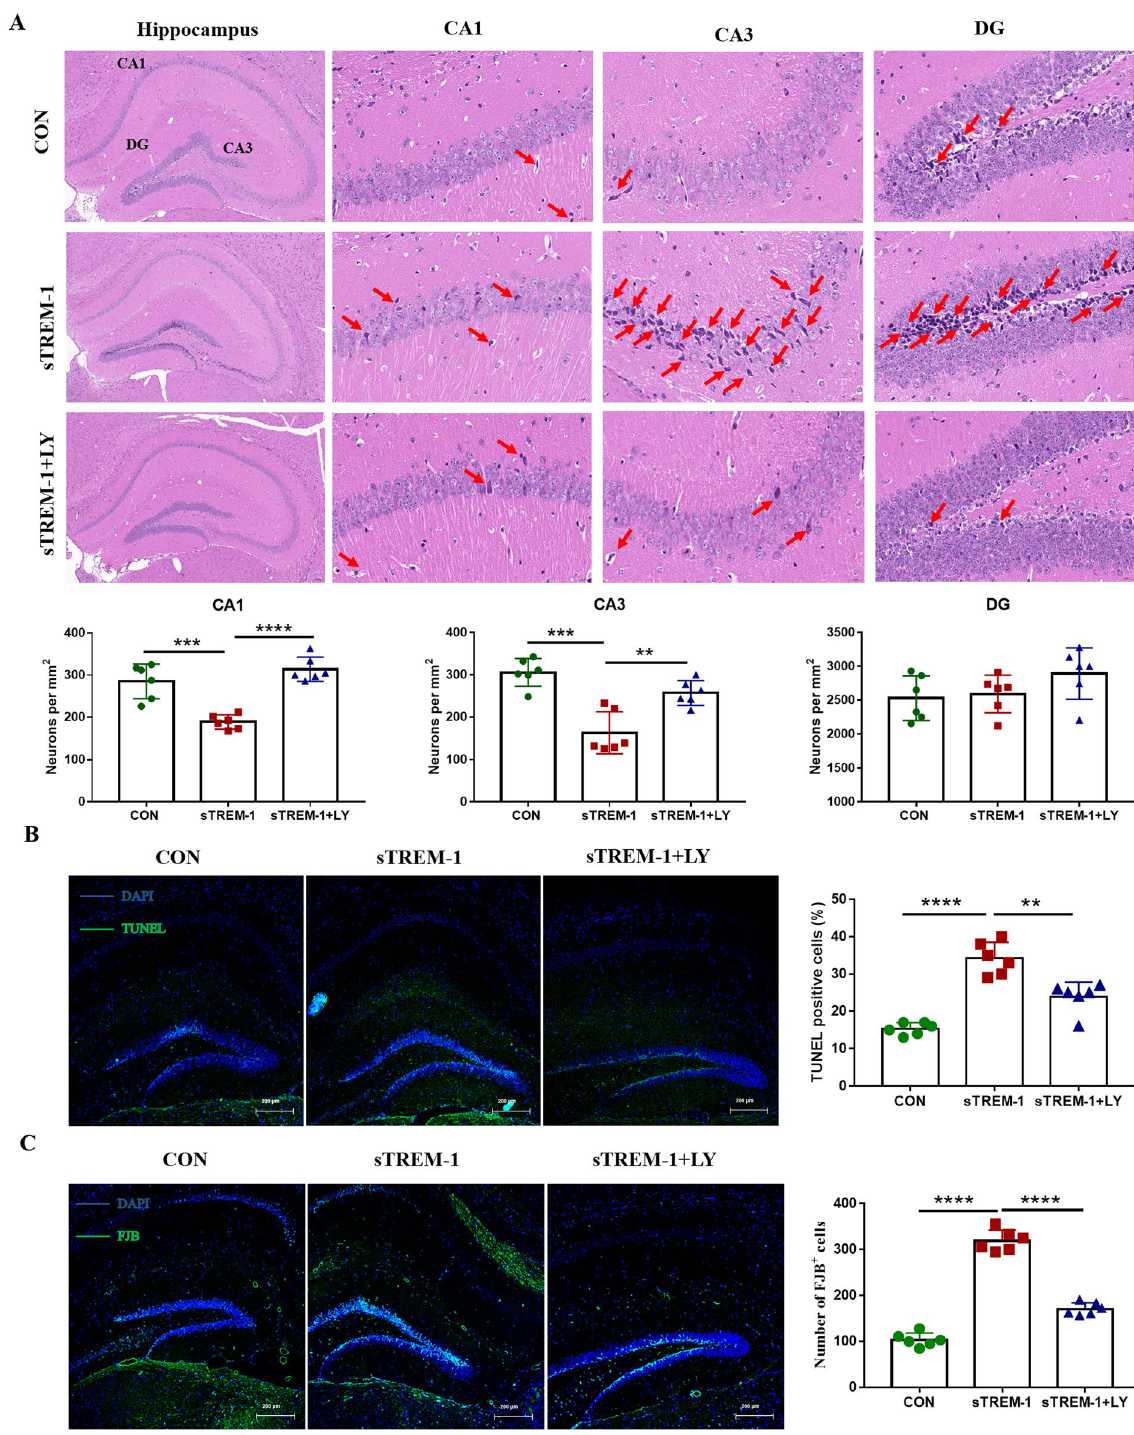
Figure 8. Inhibition of PI3K-AKT signaling pathway improves sTREM-1 induced hippocampal injury in mice. (A) H&E staining was used to observe the morphological changes of neurons in the CA1, CA3, and DG areas of the mouse hippocampus, n = 6. (B) Representative fluorescence image of hippocampal TUNEL staining of mice; scale bar is 200 μm; and the percentage of TUNEL positive cells in the entire hippocampus, n = 6. (C) Representative fluorescent images of hippocampal FJB staining of mice; scale bar is 200 μm; and the number of FJB positive cells in the entire hippocampus, n = 6. Data are presented as means ± SEM of at least three separate experiments, ** P < 0.01, *** P < 0.001, **** P <